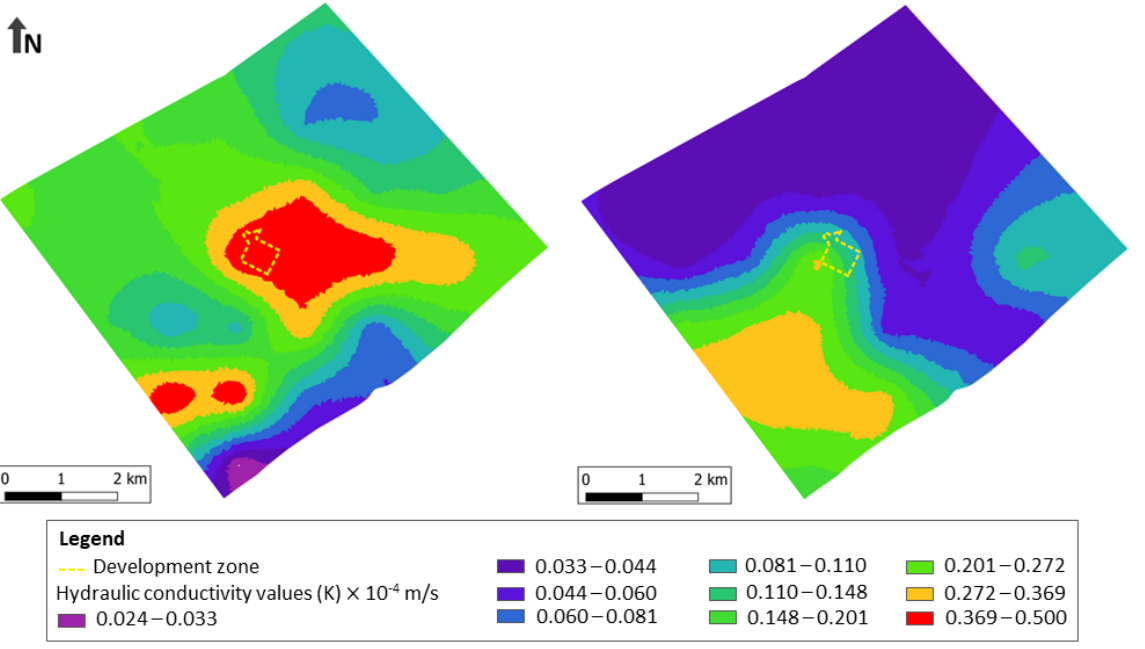
Figure 5. Spatial distribution of the hydraulic conductivity ( K ) values obtained by calibration in the shallow aquifer ( left ) and in the upper part of the fractured bedrock aquifer ( right ).